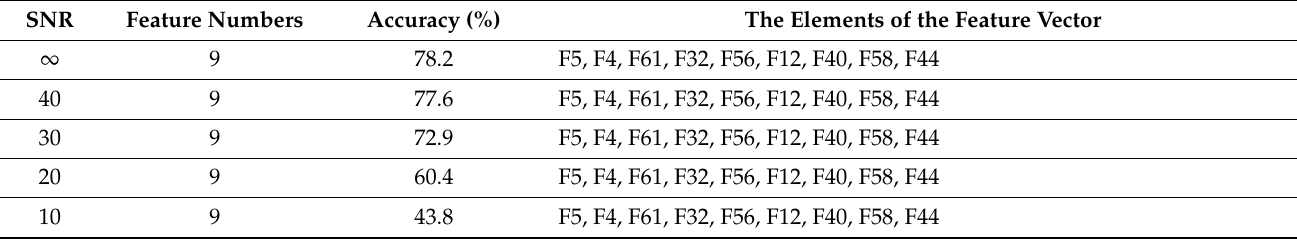
Table 8. Result of the HHT–ReliefF.